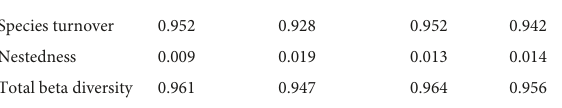
TABLE 1 Results of beta diversity partitioning for each organism group. Fungi Glomeromycota Bacteria Cercozoa